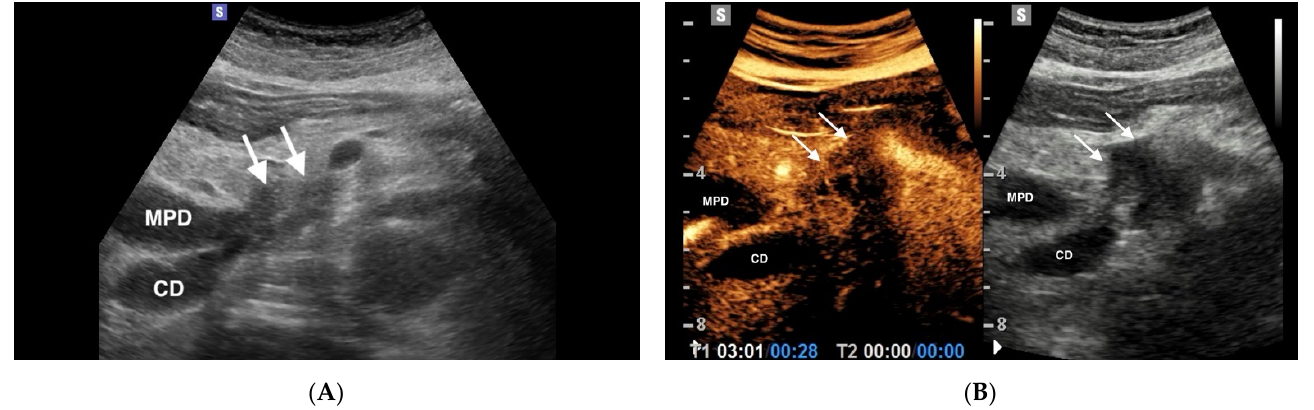
Figure 1. Pancreatic adenocarcinoma in an 89 years old woman. ( A ) B mode Ultrasonography depicts a 3.5 cm heterogenous hypoechoic mass (arrows) in the pancreatic head: severe dilation of the main pancreatic duct (MPD) and cystic duct (CD) is also appreciable. ( B ) On CEUS, in the arterial phase (28 s after the injection of c.a.) the mass is hypoechoic in comparison with the adjacent pancreatic parenchyma (arrows).